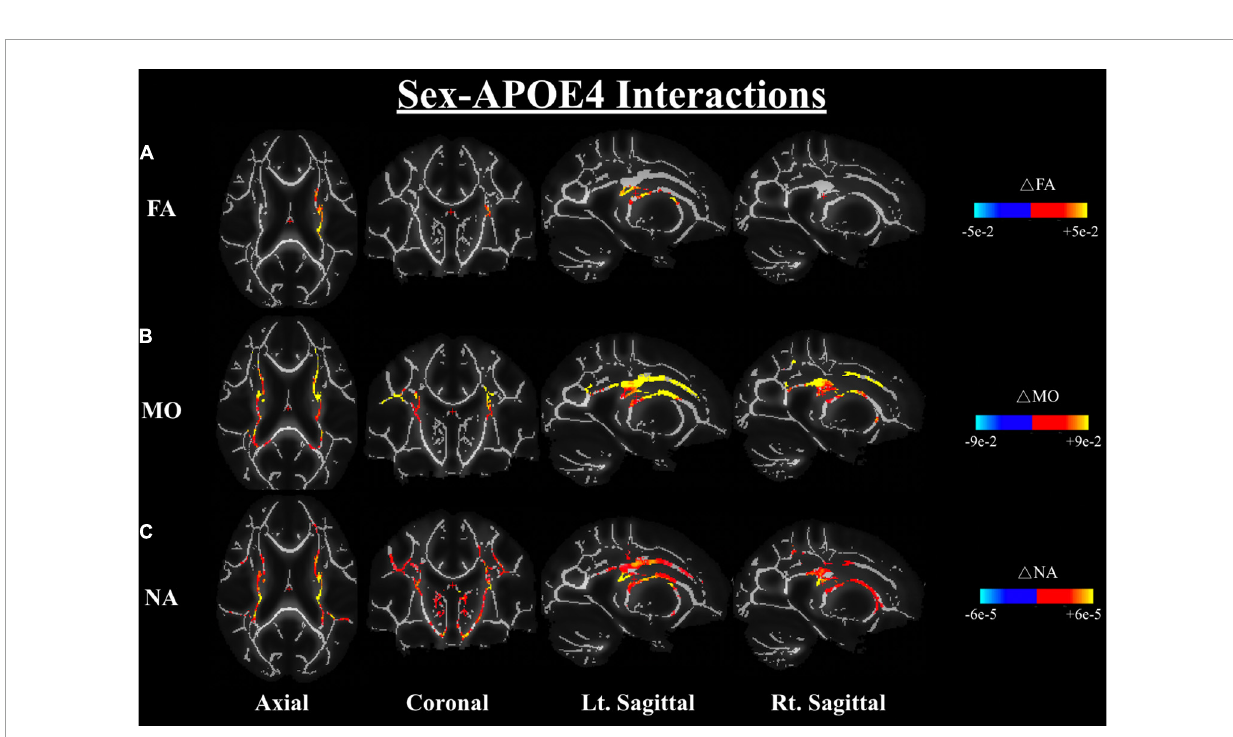
FIGURE5 Sex-APOE4 interactions in DTI metrics were assessed using two-way ANOVA (Analysis 4.2). The significant sex difference in FA (A) , MO (B) , and NA (C) were mostably found in corona radiata and internal capsule at p < 0.05, as shown in the axial, coronal, left, and right sagittal planes. In all cases, the color bar represents differences in the metrics, whereby yellow-red indicates where APOE4+ men have higher metrics than APOE4+ women. FA, fractional anisotropy; MO, mode of anisotropy; NA, norm of anisotropy; ANOVA, Analysis of